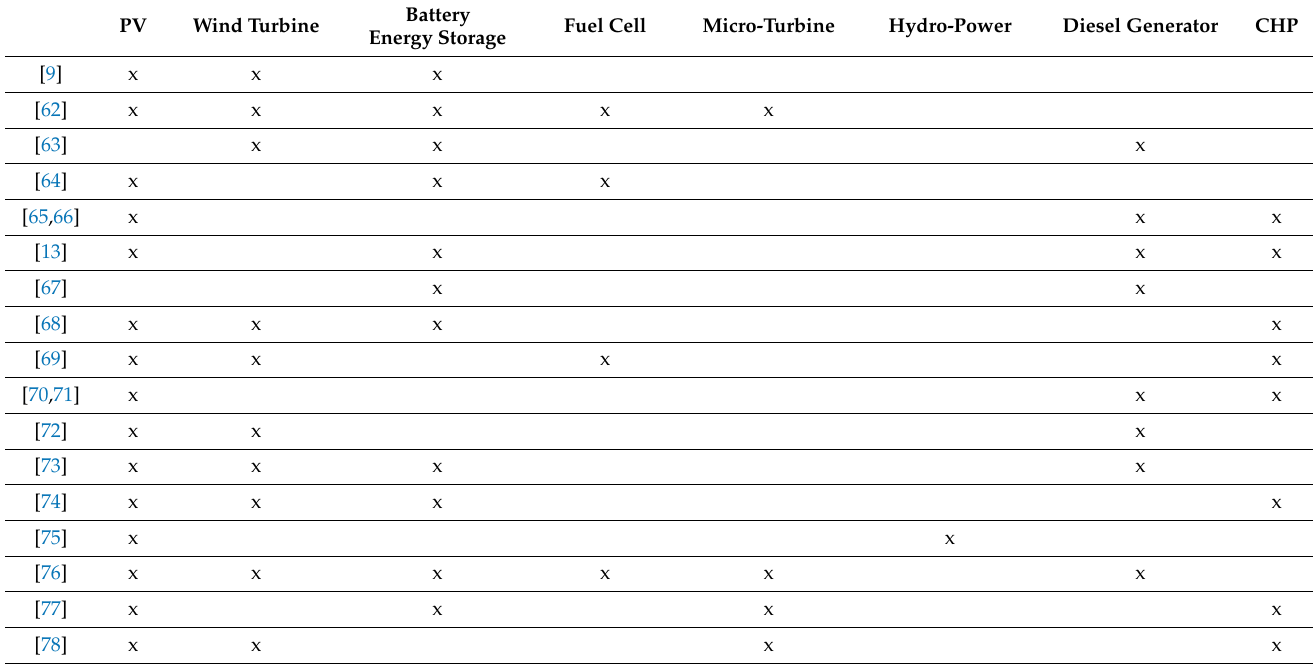
Table 1. Summary of different distributed energy resources applied in the